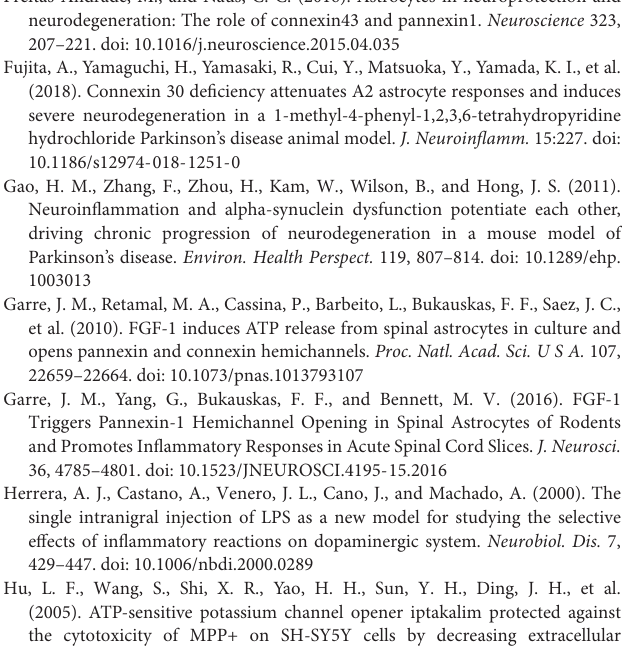
Supplementary Figure 3 | The influence of MPP + at different concentrations for 24 h on the expression of selected inflammatory cytokines, IL-6 (A) , IL-1 β (B) , and